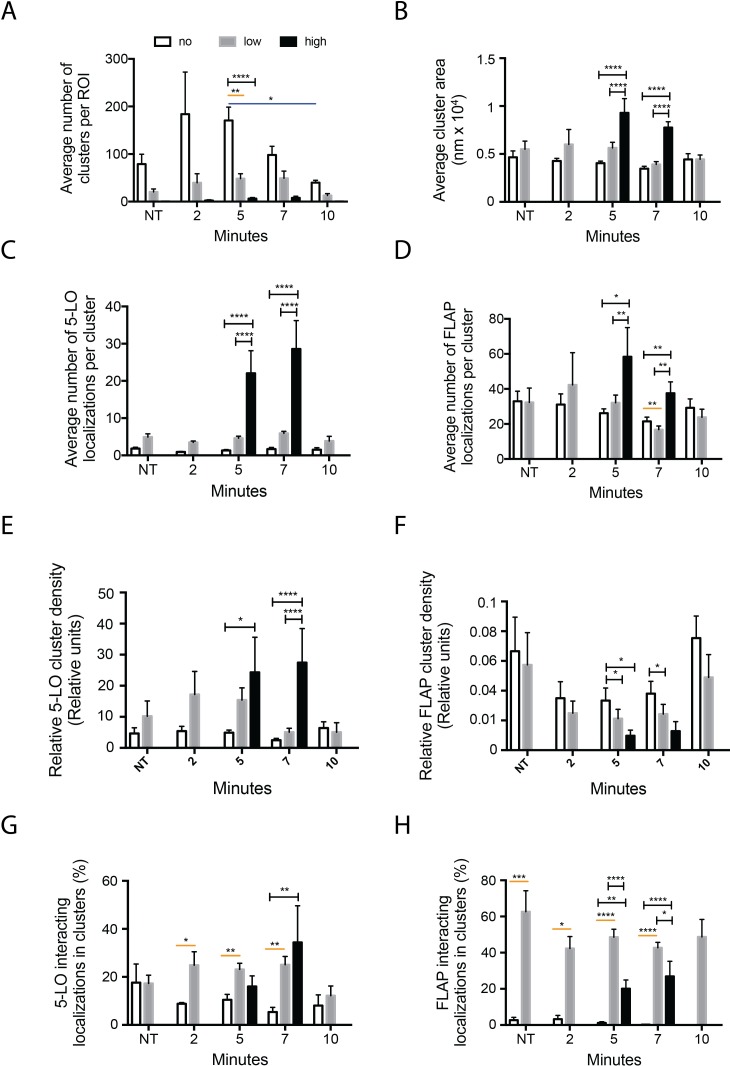
Activation changes 5-LO and FLAP cluster properties by two-color dSTORM.RBL-2H3 cells were primed with anti-TNP IgE then activated with TNP-BSA for 2, 5, 7, and 10 min, or left not treated (NT). Localization data was collected by two-color dSTORM and analyzed with Clus-DoC. Clusters were defined as having either ≥ 5 5-LO localizations or 10 FLAP localizations, and were split into 3 categories based on the number of founding localizations with a degree of colocalization (DoC) score ≥ 0.4 indicating interaction: no interaction clusters (NIC; white bars) with 0 interacting localizations; low interaction clusters (LIC; gray bars) with between 1 and 4 interacting localizations; and high interaction clusters (HIC; black bars) with 5 or more interacting localizations. (A) Average number of clusters per ROI. (B) Average cluster area. (C,D) Average number of 5-LO and FLAP localizations per cluster, respectively. (E,F) Relative density of 5-LO and FLAP in clusters, respectively. Relative density of clusters was calculated by dividing the local density within 20 nm of each localization by the average density of the cluster, a measure of the local concentration maxima within the cluster. (G,H) Percent of interacting 5-LO and FLAP localizations located in clusters, respectively. Time points for a cluster type with fewer than 3 values for that cluster type were excluded. One-way ANOVA with Tukey’s post-hoc multiple comparisons test was performed to determine significance among interaction groups where *p < 0.05, **p < 0.005 and ****p < 0.0001; within timepoint, HIC–NIC or HIC–LIC indicated by black brackets, LIC–NIC by orange line; between timepoints by blue line. Bars show mean ± SEM of clusters within 4 to 21 cells over 3 independent experiments.